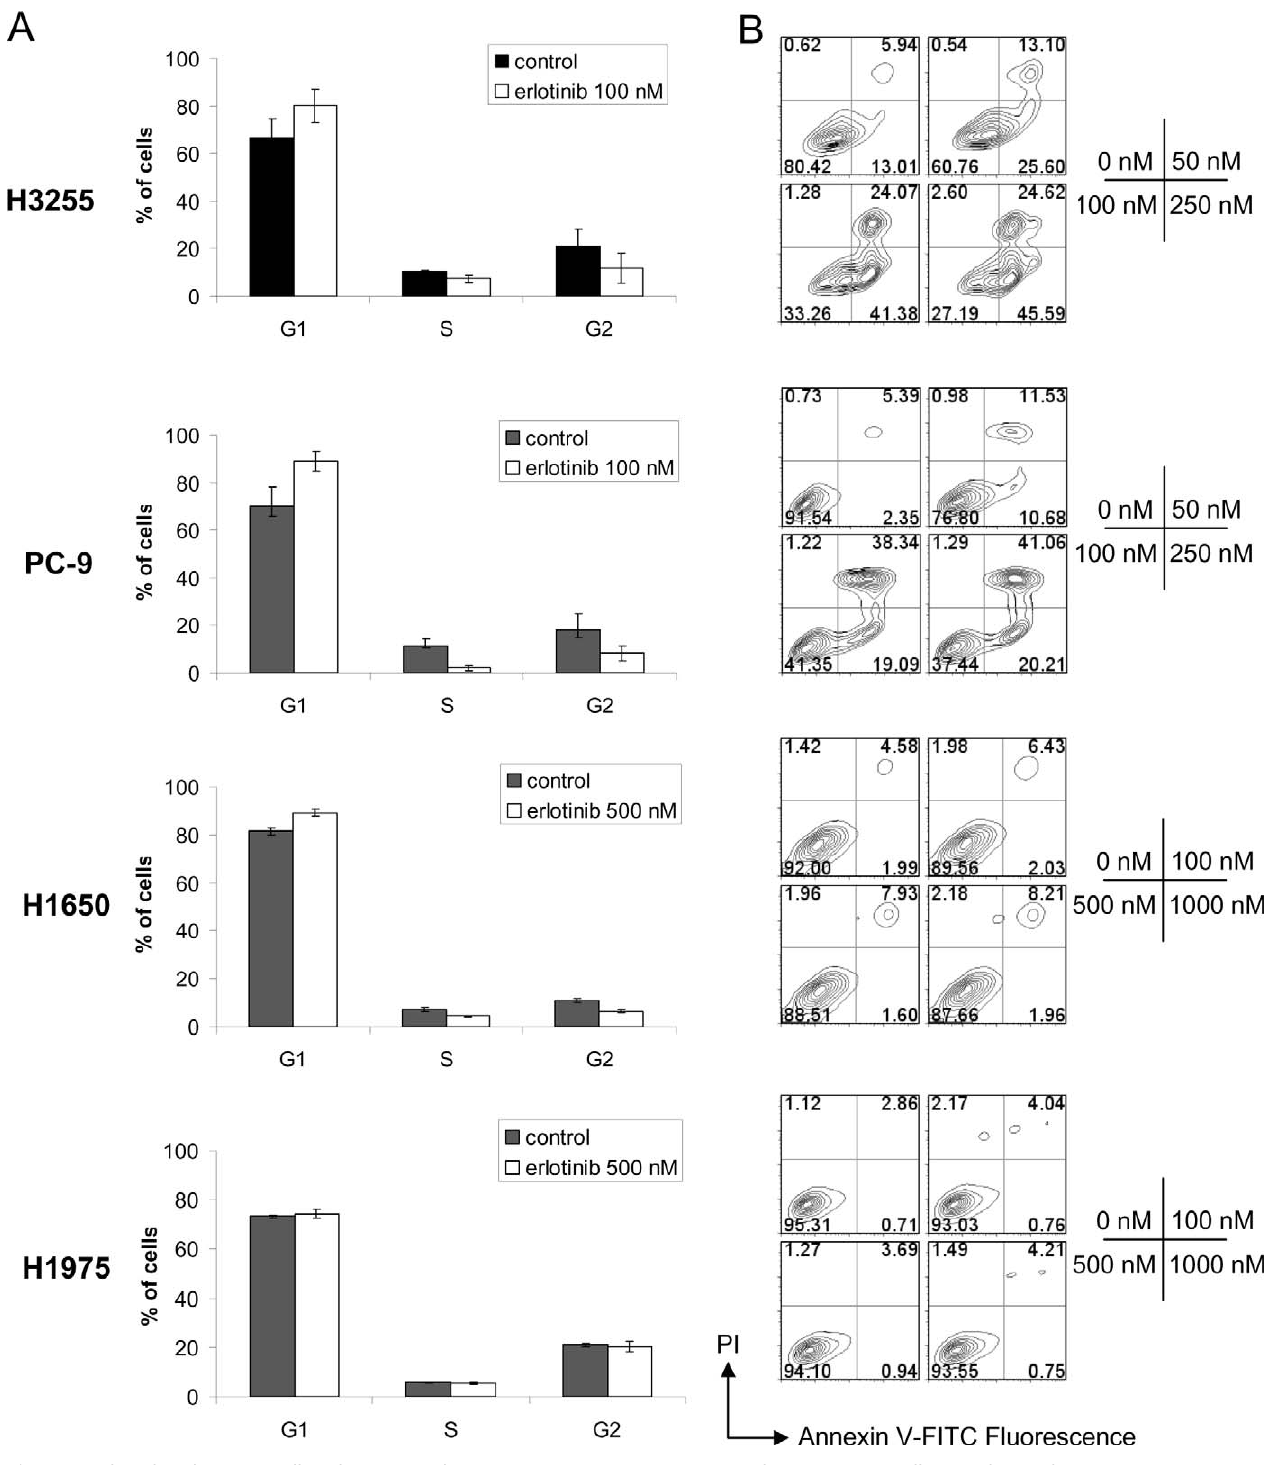
Figure 2. Erlotinib Induces G1 Cell Cycle Arrest and Apoptosis in Drug-Sensitive Lung Adenocarcinoma Cell Lines That Harbor EGFR Mutations (A) Cell lines treated with either DMSO or indicated concentrations of erlotinib for 24 h were used for cell cycle analysis as described in the Methods. Data represent the mean 6 standard deviation of three independent experiments. (B) Cell lines treated with either DMSO or different concentrations of erlotinib for 48 h were used for annexin V/PI apoptosis assays as described in Methods.